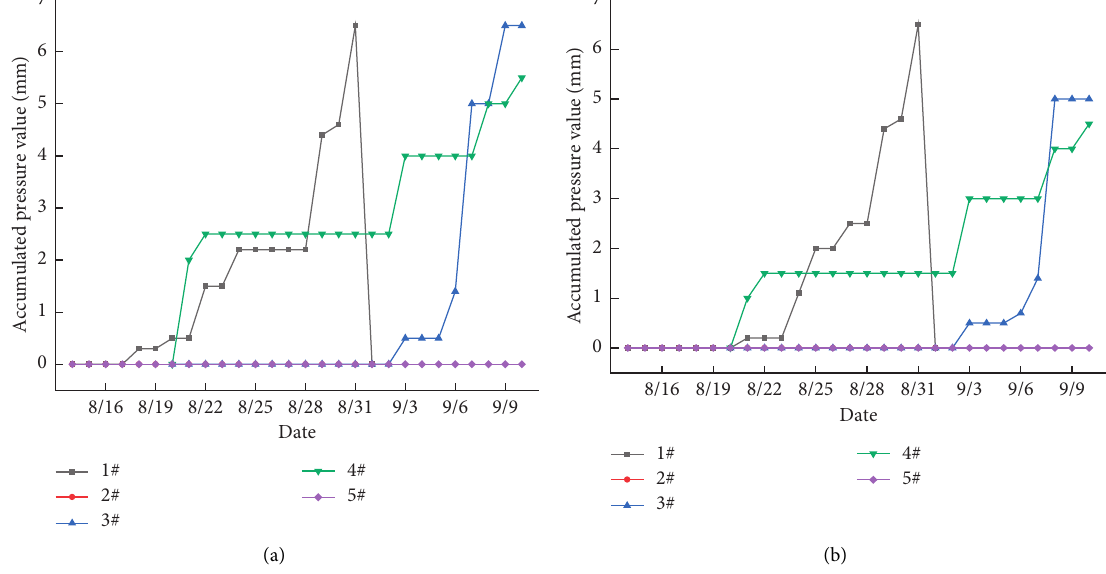
Figure 12: Medium base point monitoring data. (a) Single hydraulic prop support. (b) Anchor cable